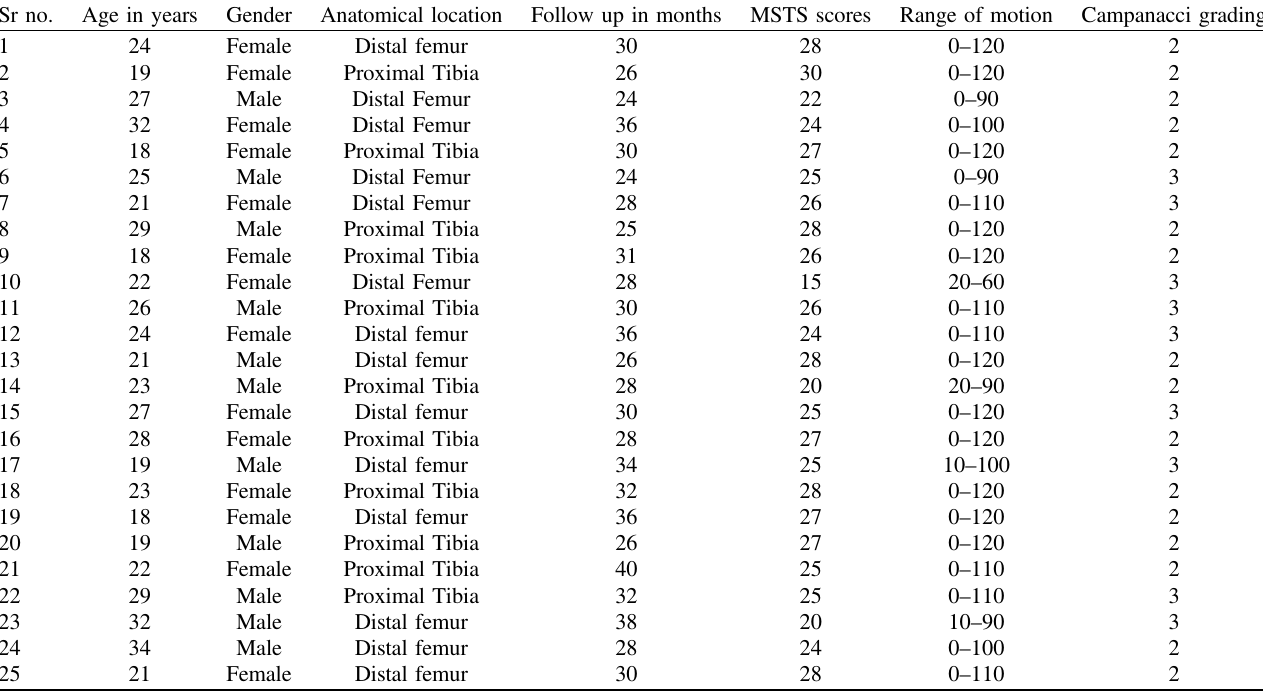
Table 1. Summary of demographic data and results from the study. Sr no.